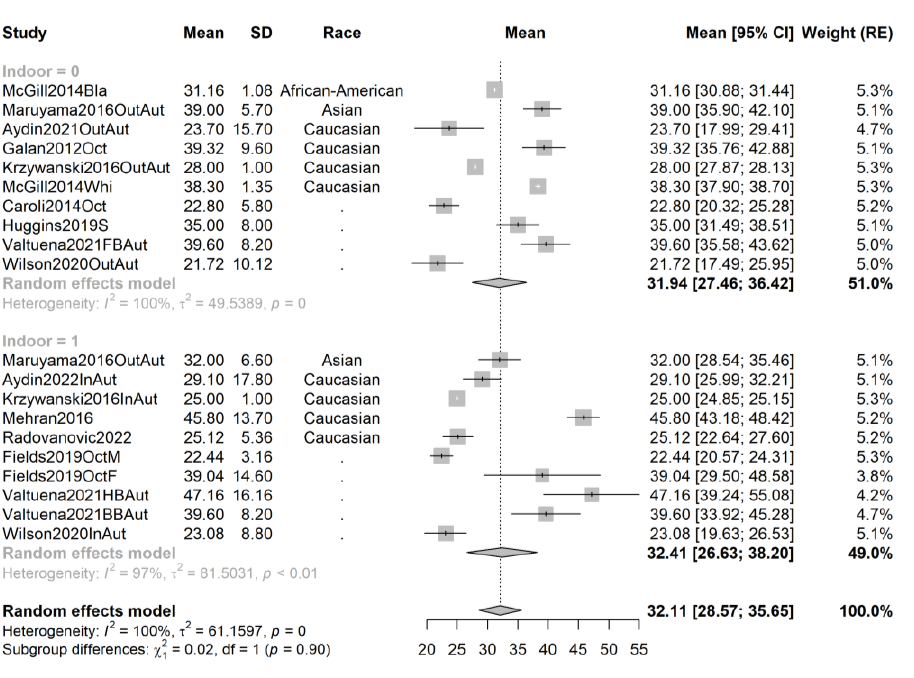
Figure 8. Forest plot of all studies performed in autumn sorted by athletes’ race. Studies [40,43,51,52,55,61,63,65–67,69,70].